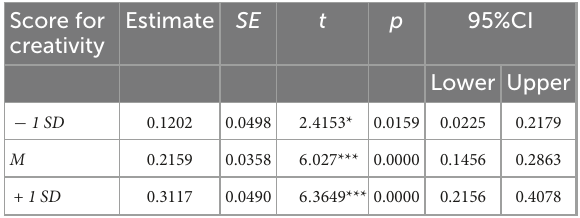
TABLE 4 Conditional effects at specific levels of creativity. Score for Estimate SE t creativity